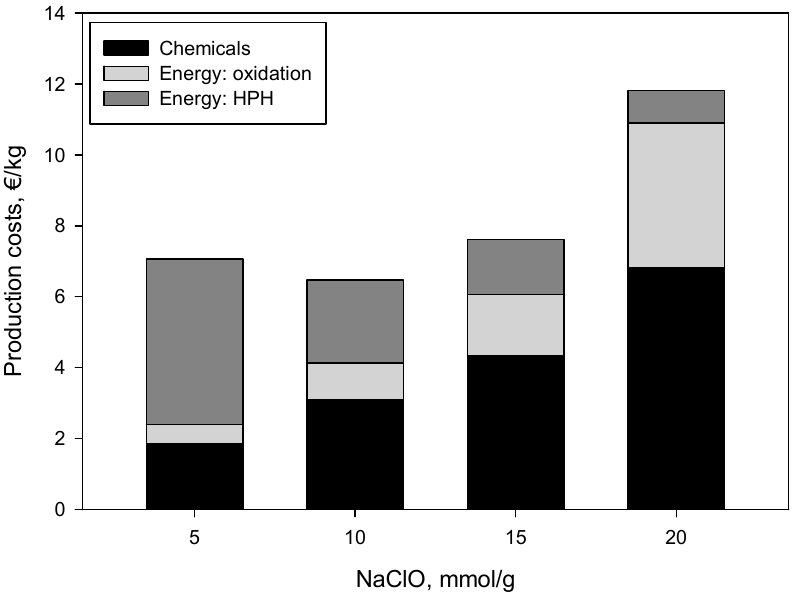
Figure 4. Production costs of the CNF obtained with different amounts of NaClO.